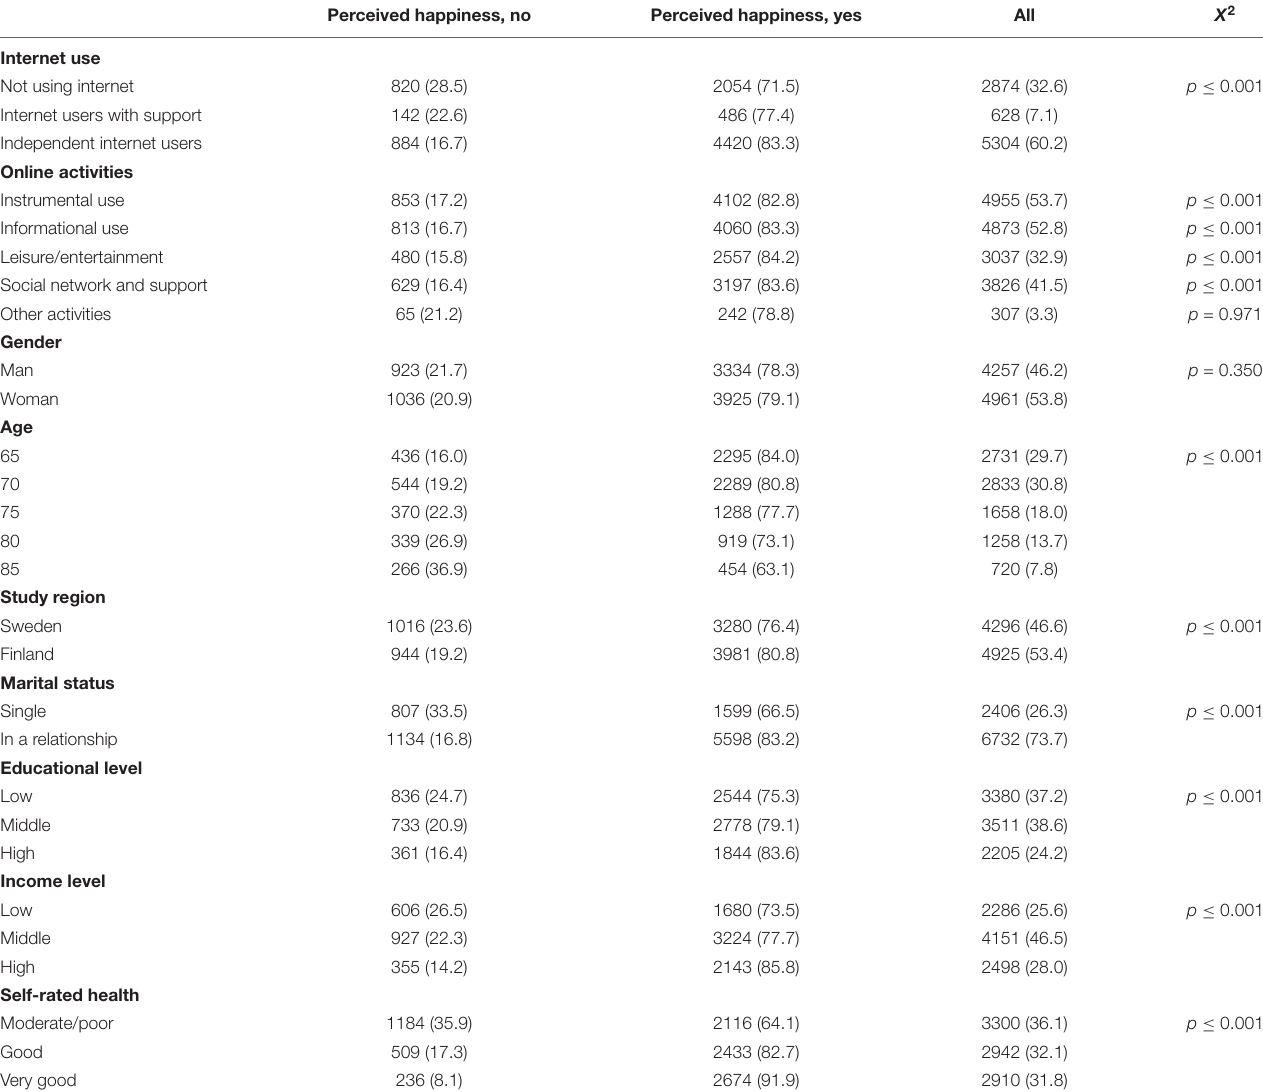
TABLE 2 | The distribution of perceived happiness among all the included variables and results from Person’s chi-square test presenting between-group comparison of perceived happiness. Perceived happiness, no Perceived happiness, yes All X